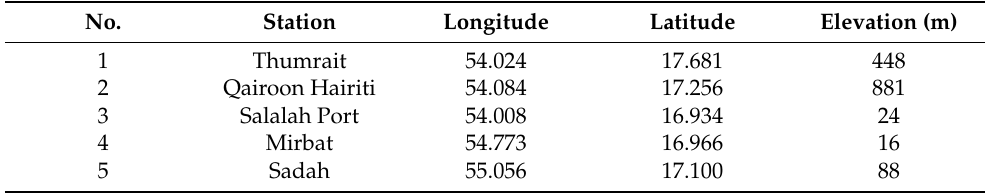
Table 1. Longitude and altitude for different observing stations over Dhofar. No. Station Longitude Latitude Elevation (m)